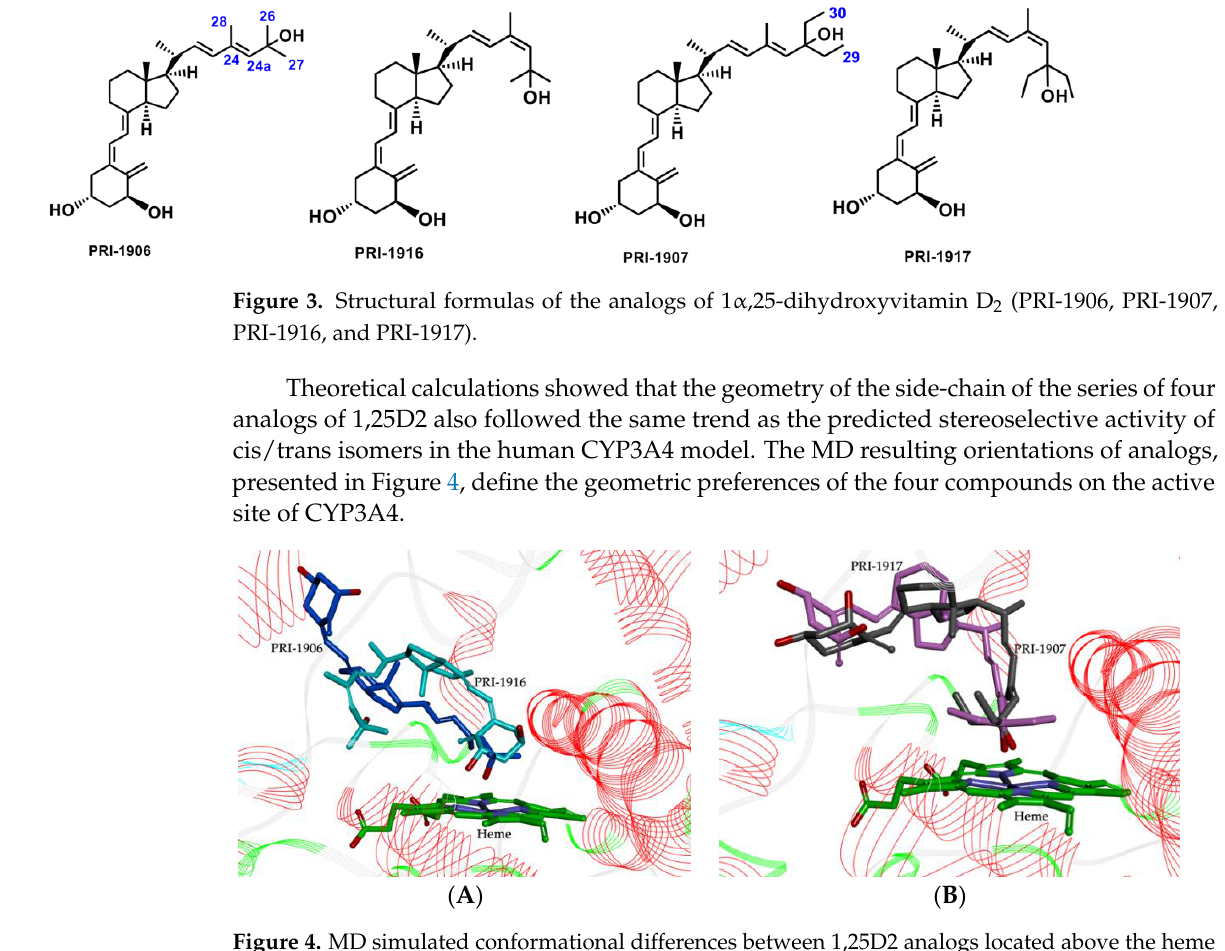
Figure 4. MD simulated conformational differences between 1,25D2 analogs located above the heme ring. ( A ) PRI-1906 (C atoms shown as blue) and PRI-1916 (C atoms shown as cyan); ( B ) PRI-1907 (C atoms shown as grey) and PRI-1917 (C atoms shown as pink).